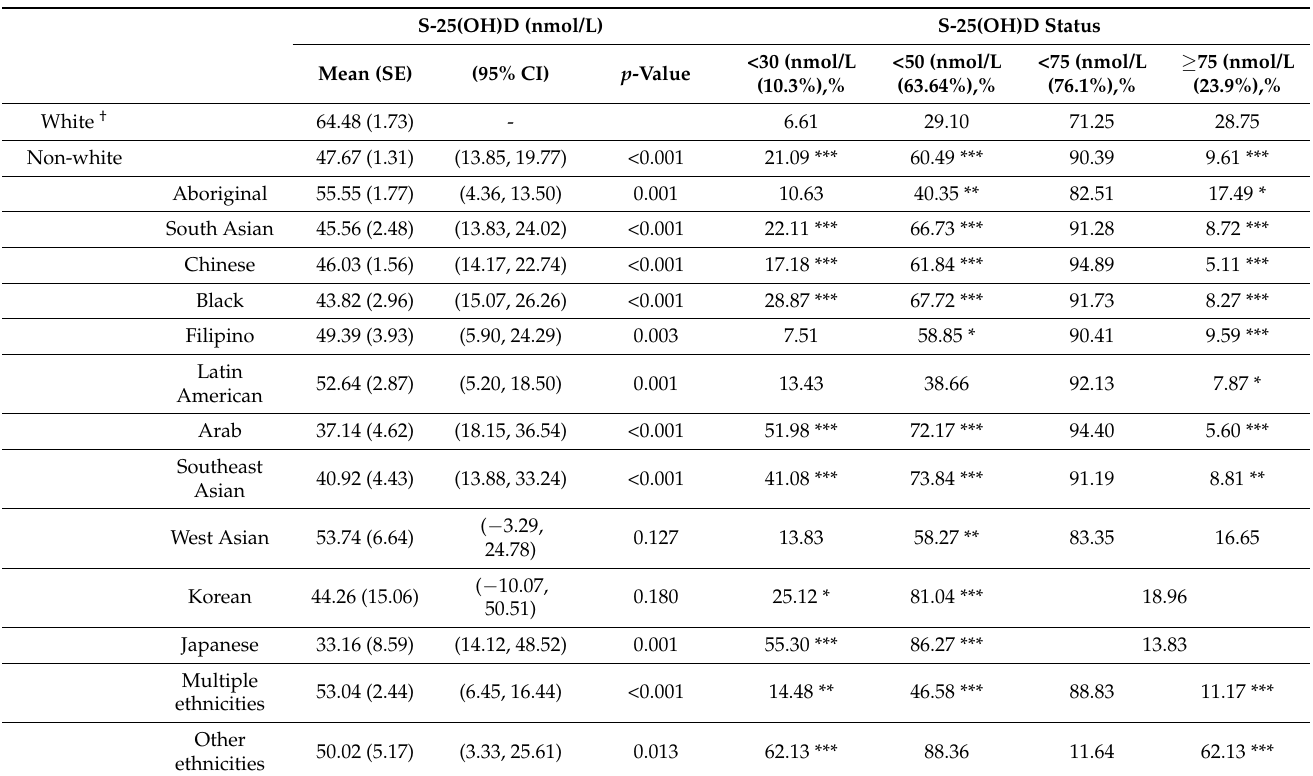
Table 3. Weighted mean S-25(OH)D (nmol/L) and vitamin D status by ethnicity using Cycles 3 and 4 of Canadian Health Measures Survey